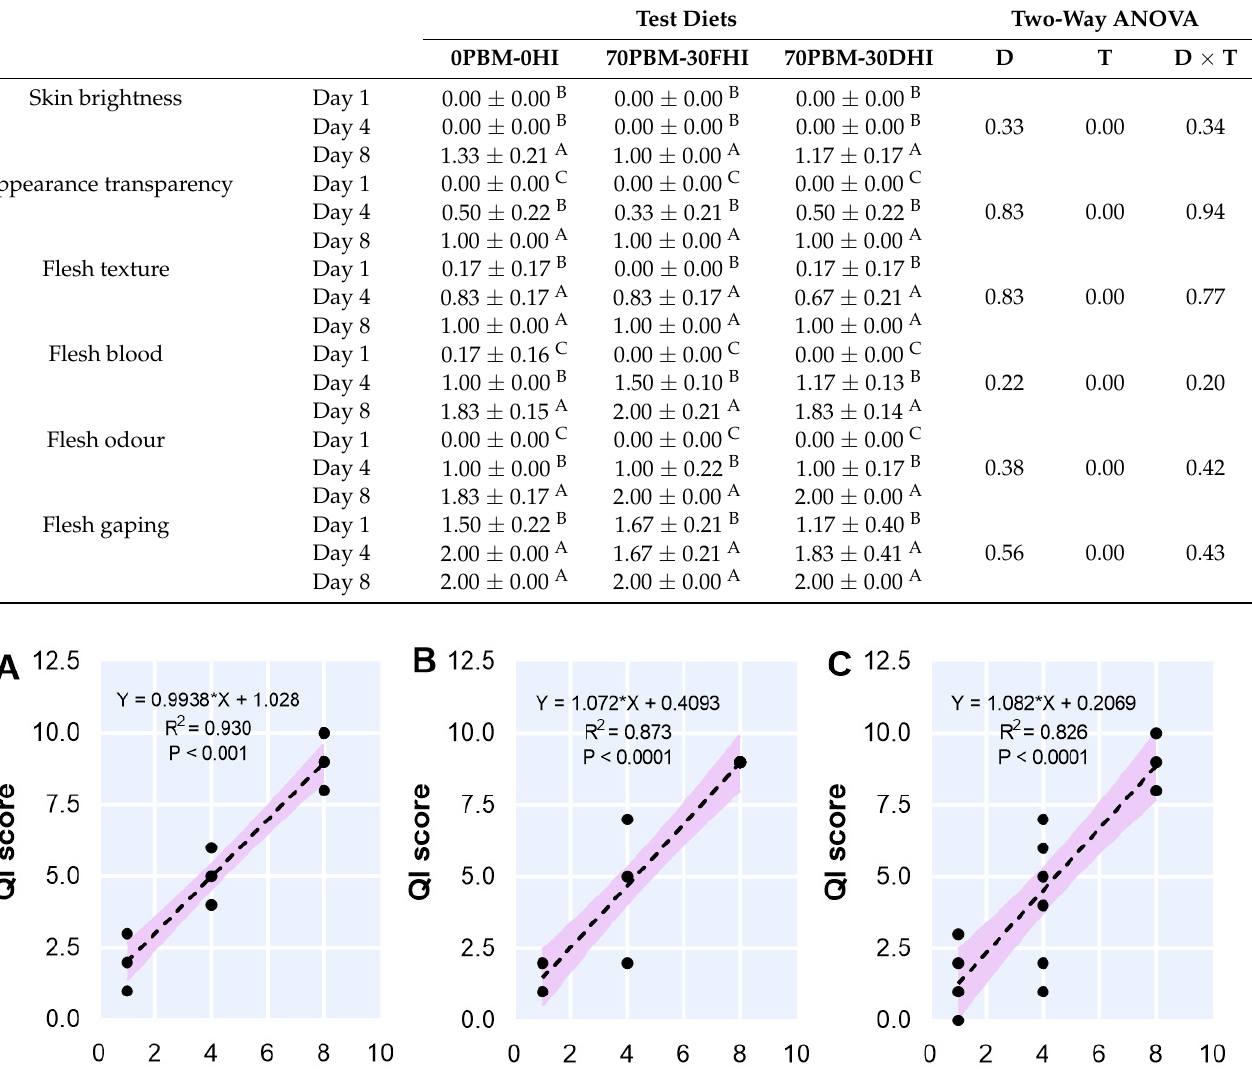
Table 5. Results for the sensory parameters evaluated using the quality index (QI) method, showing the skin brightness, appearance transparency, flesh texture, flesh blood, flesh odor, and flesh gaping values for barramundi fillets ( n = 6) from fish fed PBM-HI-based diets during chilled storage. Diet, D; storage time, T. Different superscripts capital letters indicate significant difference between the storage days.